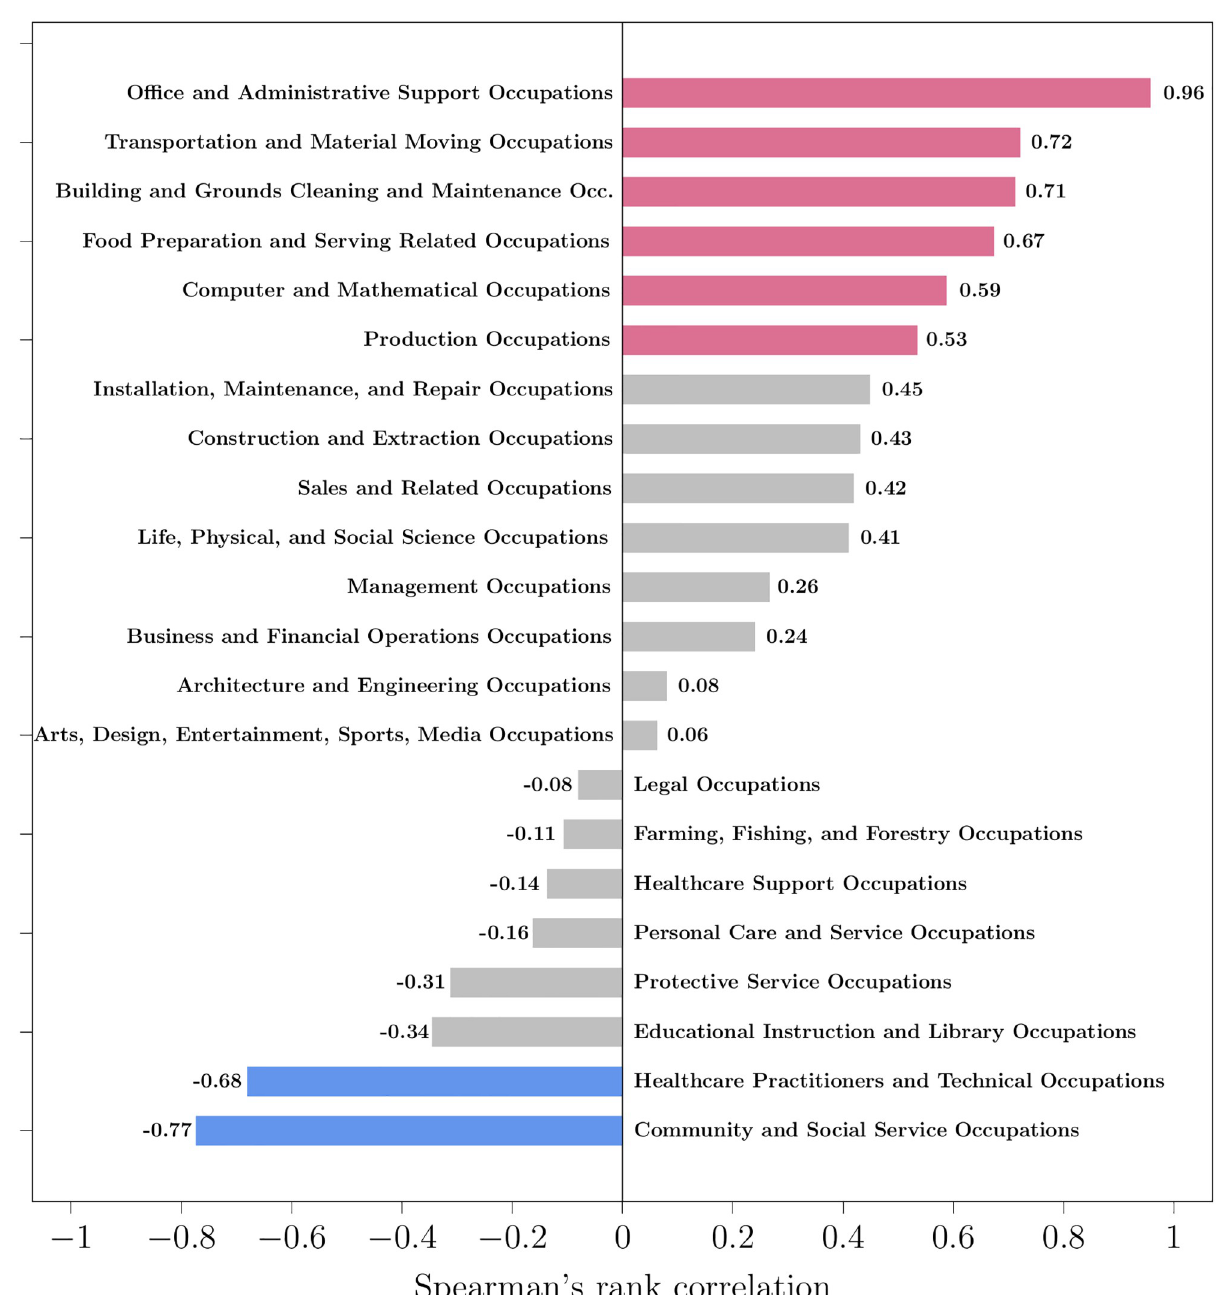
Fig 15. Spearman’s rank correlation coefficient of the media frequency of SOC groups with employment. The red-colored bars have positive correlation: media frequency and employment have the same trend. The blue-colored bars have negative correlation: media frequency and employment have opposite trends. The grey-colored bars mean that the correlation is not statistically significant ( α =